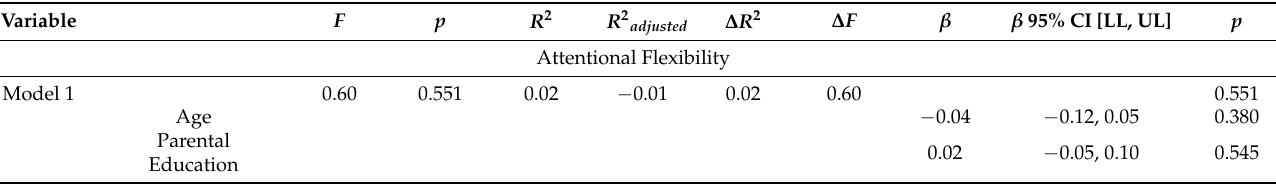
Table A3. Linear regression results for language exposure